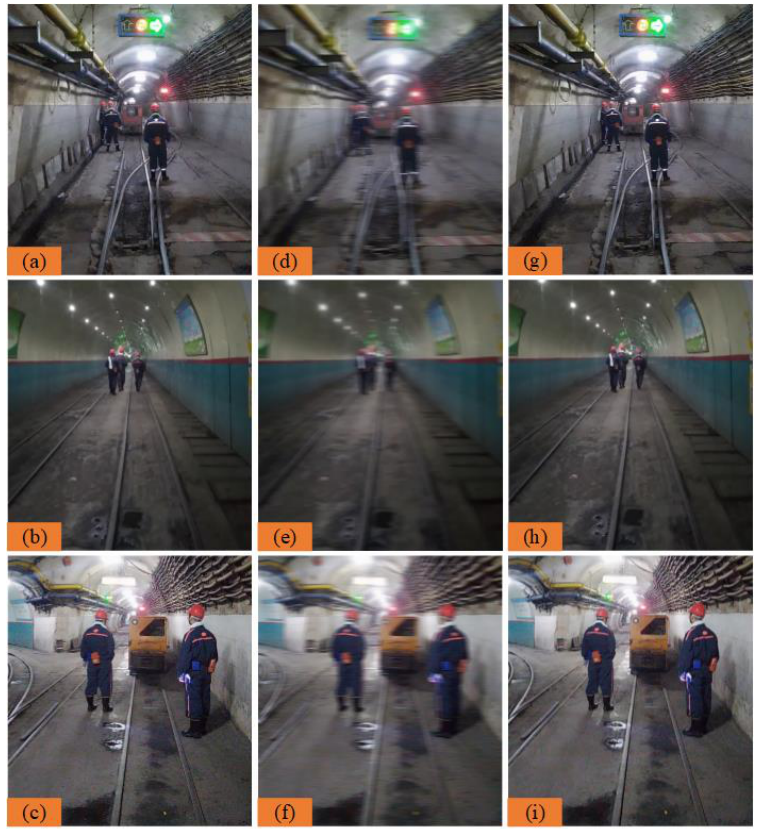
Figure 8. Partial dataset pictures. ( a – c ) Clear; ( d – f ) blurred; and ( g – i ) deblurred pictures.